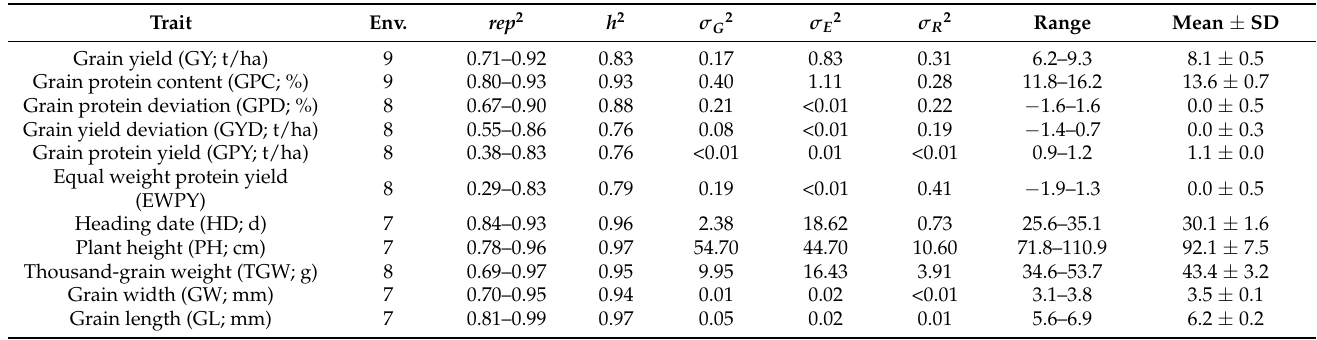
Table 1. Summary of phenotypic data for the BMWpop across ten environments: number of environ- ments (Env.) for genetic analysis (filtered for rep 2 ≥ 0.3 for all measured traits), range of repeatability ( rep 2 ), heritability ( h 2 ), genotypic variance ( σ G 2 ), environmental variance ( σ E 2 ), residual variance ( σ R 2 ), range of adjusted means, overall mean and standard deviation (SD).